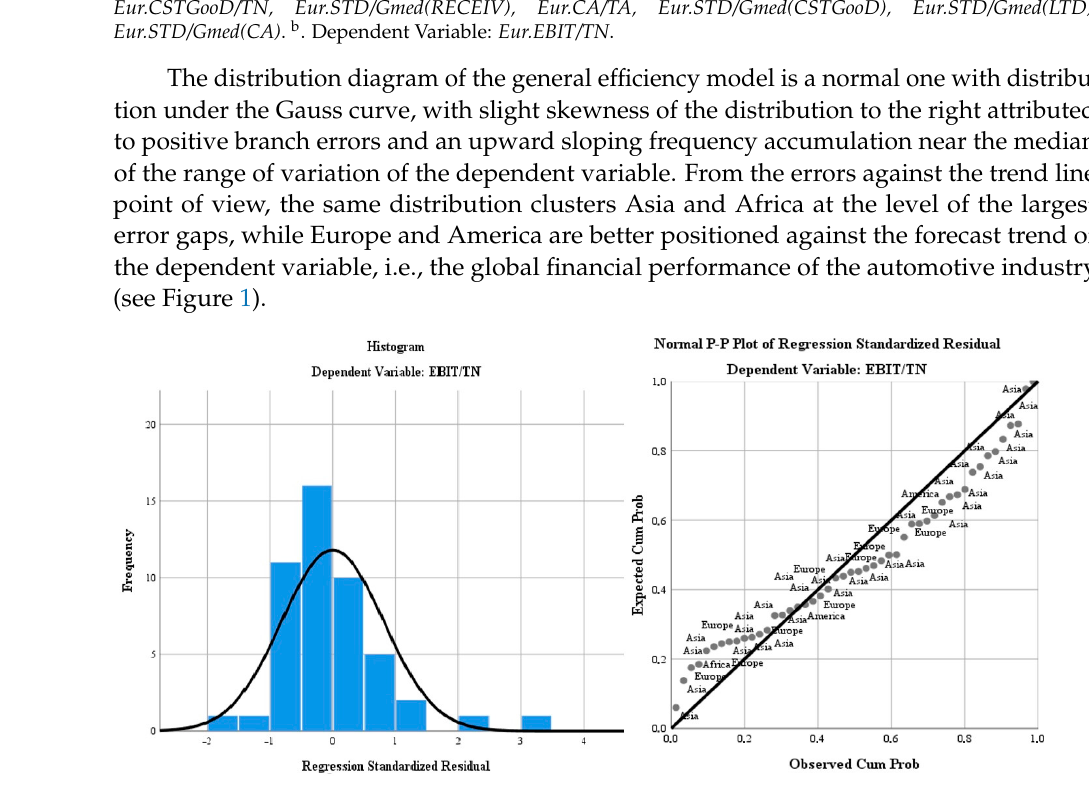
Figure 1. Distribution diagram of the dependent variable of the overall average overall performance in the automotive industry.